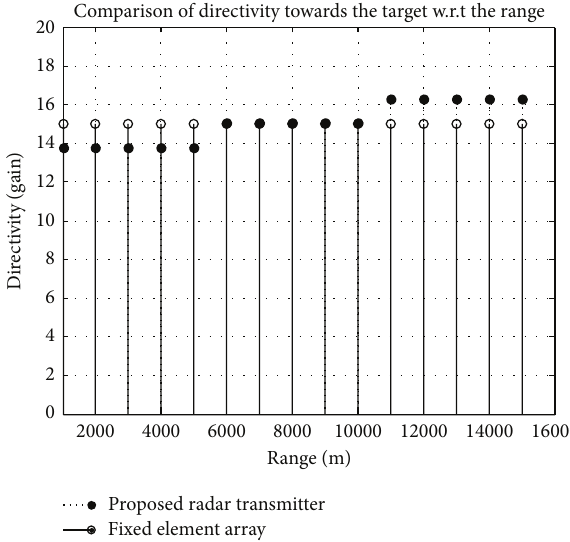
Comparison of directivity towards the target w.r.t the range